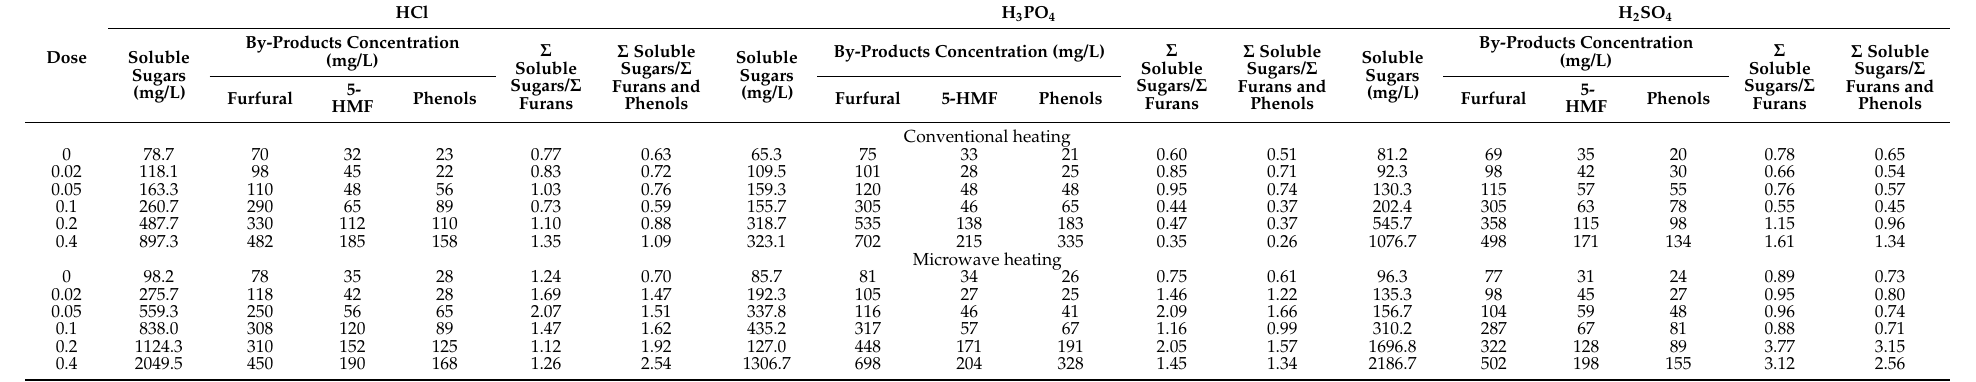
Table 4. Generation of by-products, depending on heating method and acid